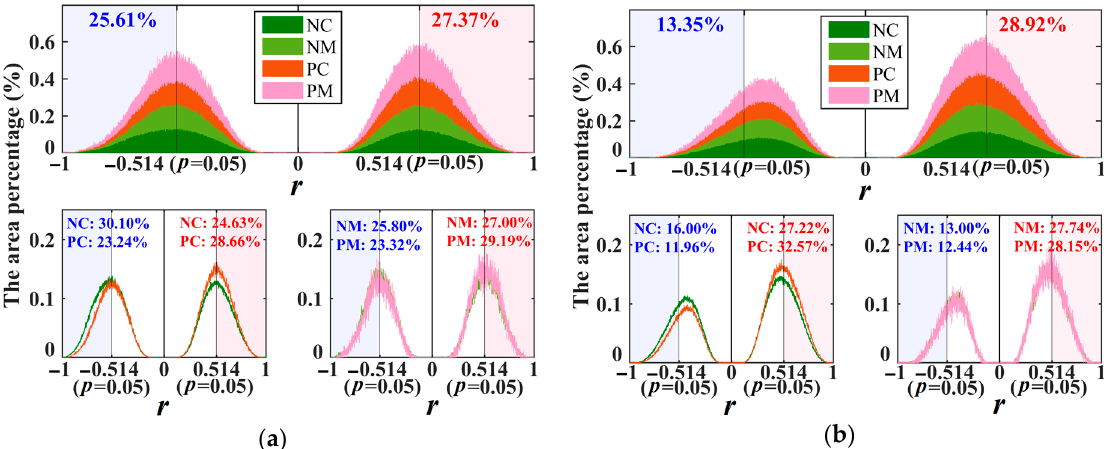
Figure 5. Comparison of histograms for r , which corresponds to | r | max of different forest types during the ( a ) pregrowing season (January–April) and ( b ) growing season (May–September). The PC, PM, NC, and NM represent planted coniferous, planted mixed, natural coniferous, and natural mixed forests, respectively. The correlation significant at p < 0.05 is equivalent to | r | > 0.514 [36].